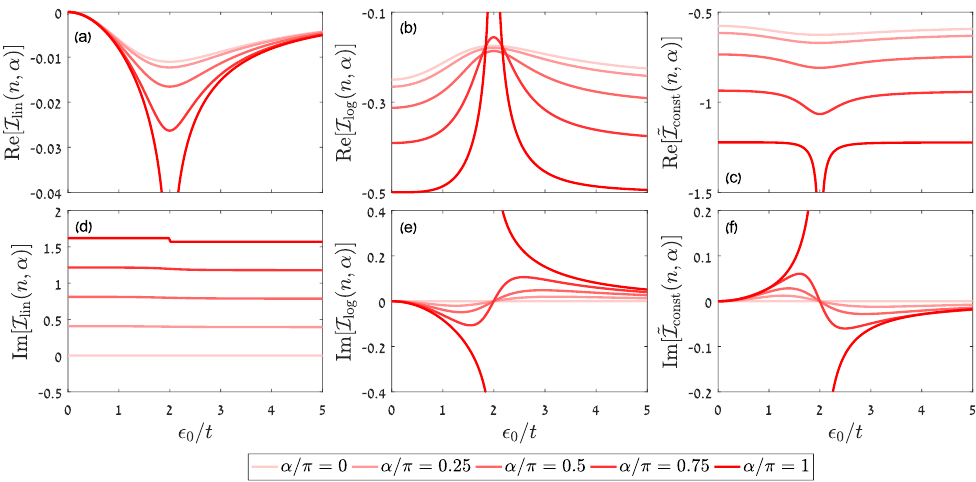
Figure 10: The single impurity model: Coefficients in the analytical asymptotic ex- ( α ) in Eq. (34), as a function of ε pression for ln Z n The remaining parameters are set to n = 2, k panels (a)–(c) show the real parts of the coefficients, and the bottom panels (d)–(f) show their imaginary parts. Panels (a) and (d) are for the coefficient I and (e) are for I , and panels (c) and (f) are for ˜ I log